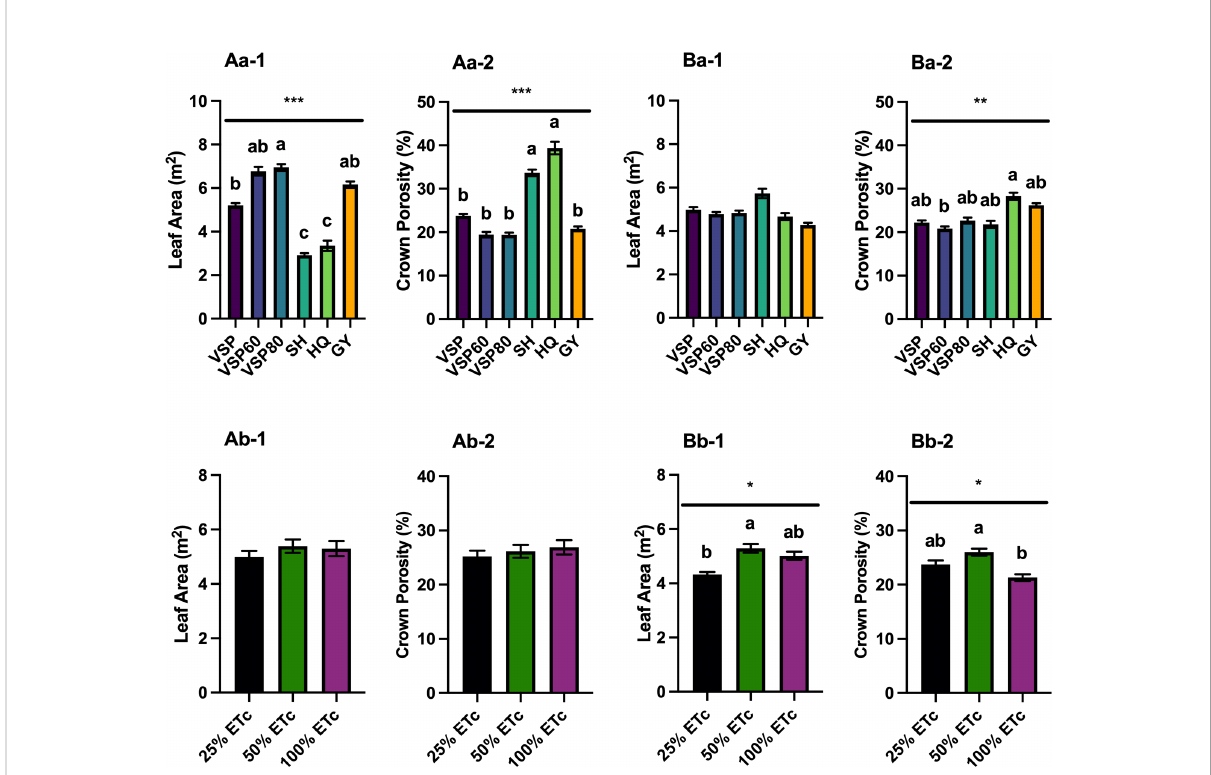
FIGURE 2 Canopy Architecture as Affected by Trellis Systems and Applied Water Amounts of ‘ Cabernet Sauvignon ’ in Oakville, CA, USA in (A) 2020 and (B) 2021; (a) the main effect of trellis systems, (b) the main effect of applied water amounts; (1) leaf area, (2) crown porosity. Error bars represent one standard deviation from the mean, letters represent ranking after Tukey ’ s post hoc analyses. Asterisks represents signi fi cant levels p , ‘ *** ’ p < 0.001, ‘ ** ’ p < 0.01, ‘ * ’ p < 0.05. VSP, vertical shoot position; VSP60, vertical shoot position 60°; VSP80, vertical shoot position 80°; SH, single hire wire; HQ, High-Quadrilateral; GY, guyot-pruned vertical shoot position; ET c , crop